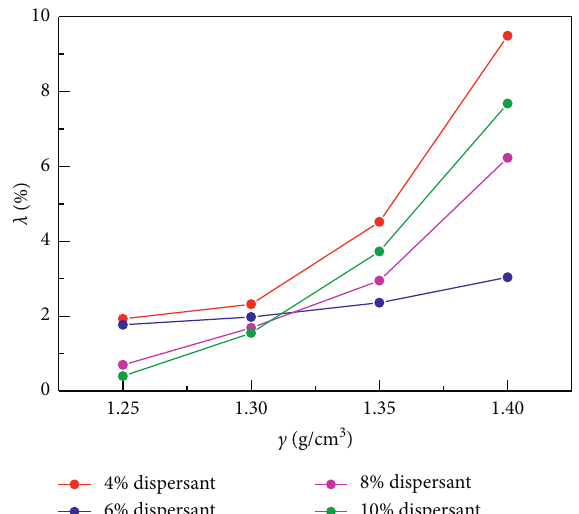
Figure 10: Effect of specific gravity on the empirical stickiness ratio.